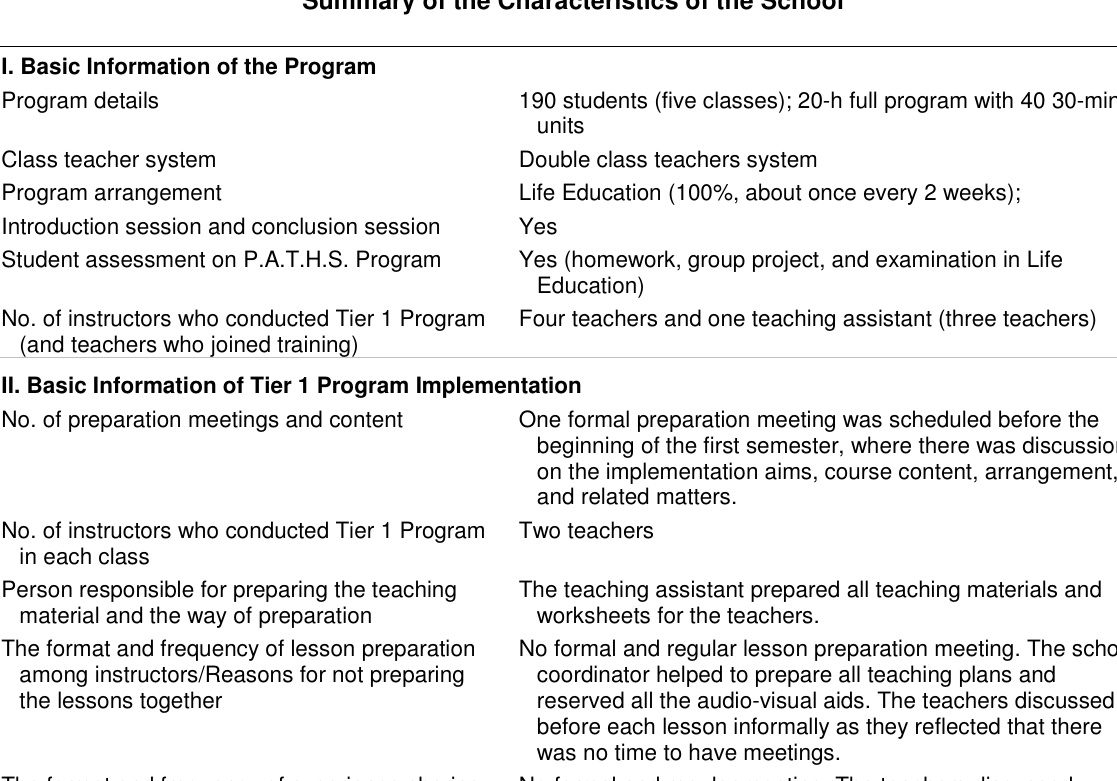
Summary of the Characteristics of the